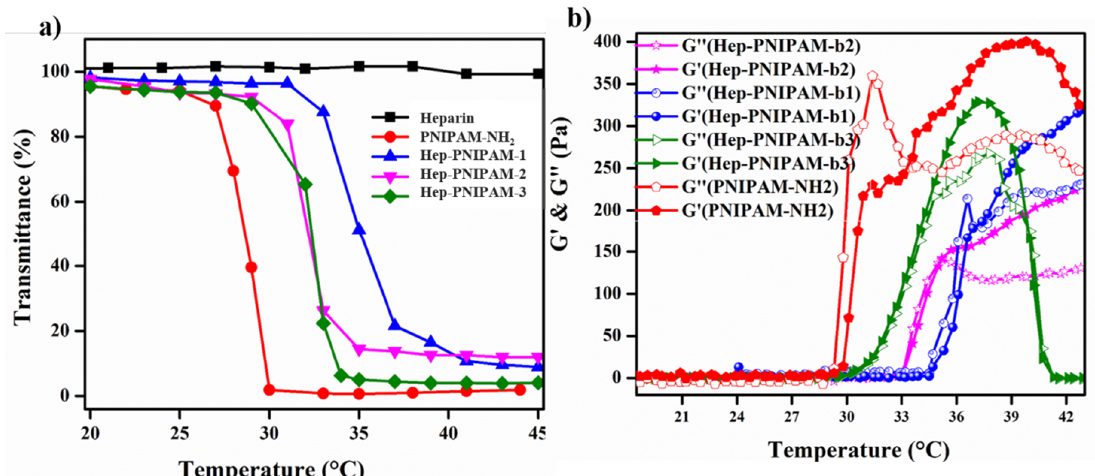
Figure 3. ( a ) Temperature-dependent transmittance for aqueous solutions of heparin, PNIPAM-NH2, and copolymers with various PNIPAM grafting ratios on heparin. ( b ) Storage modulus G’ and loss modulus G” as functions of temperature for PNIPAM and heparin copolymers grafted with different